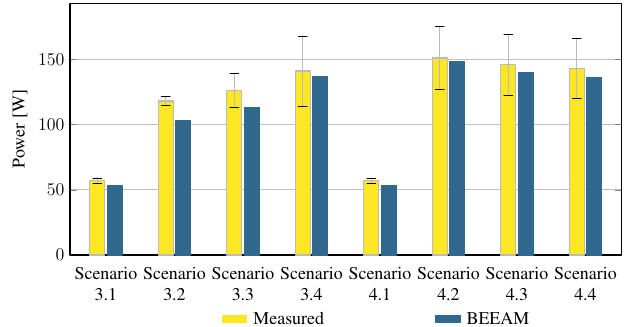
Figure 21. Predicted versus measured total system power losses, Scenarios 3 and 4.